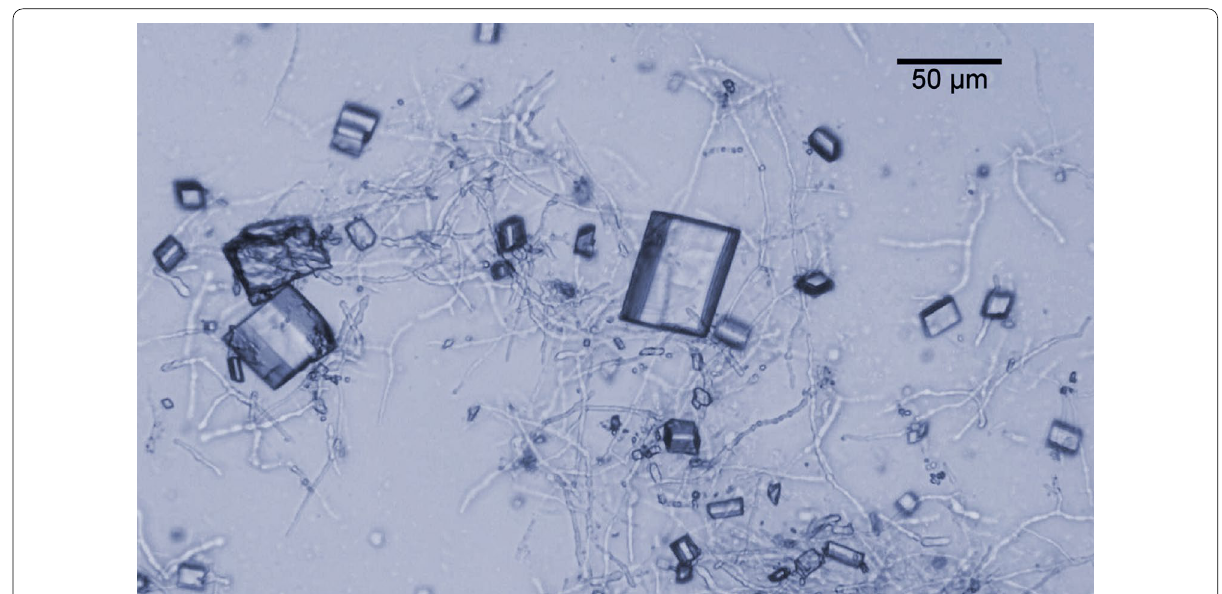
Fig. 2 Mycelia of D-221704 growing at pH 3.5 in fed-batch culture, with crystals of mucic acid. Scale bar represents 50